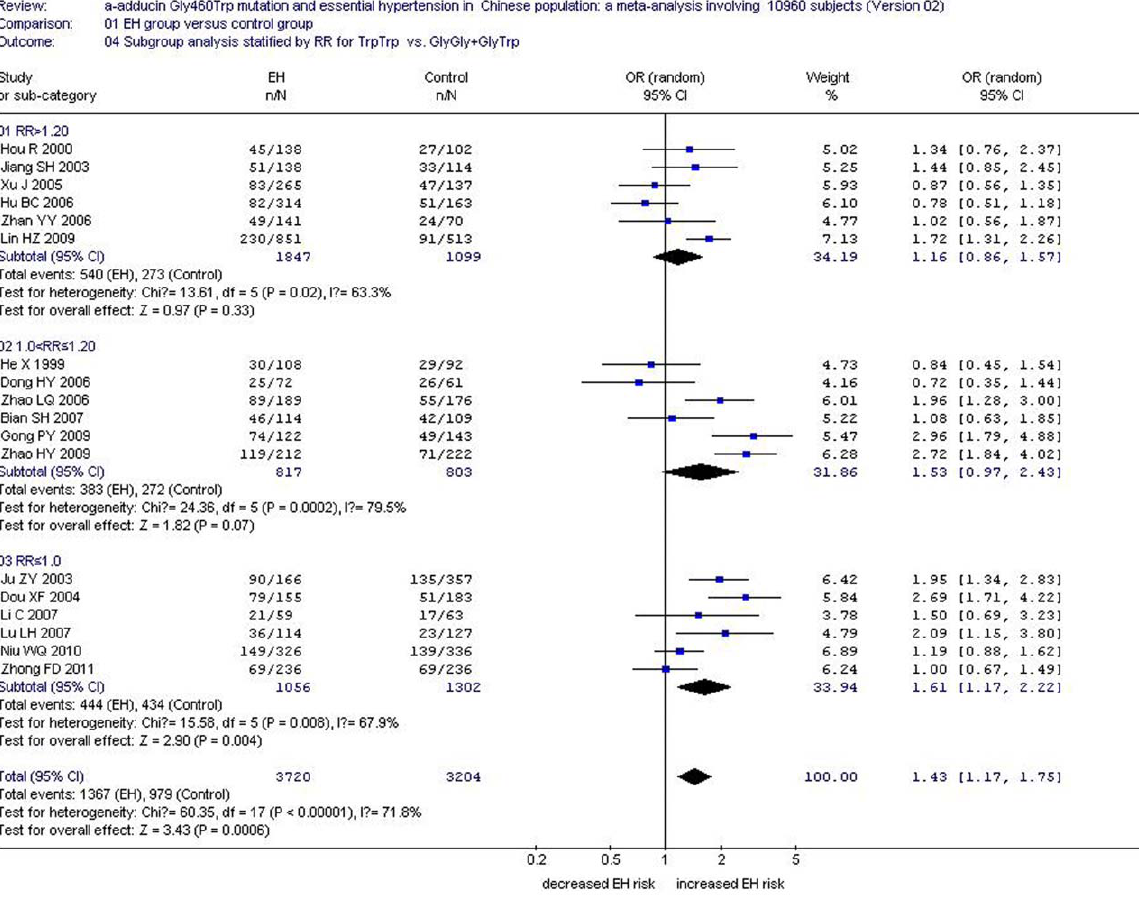
Figure 9. Forest plot of essential hypertension associated with a -adducin Gly460Trp gene polymorphism under a recessive genetic model (TrpTrp vs.GlyGly + GlyTrp) stratified by RR in Chinese Han population. RR: the ratio of case size to control size.